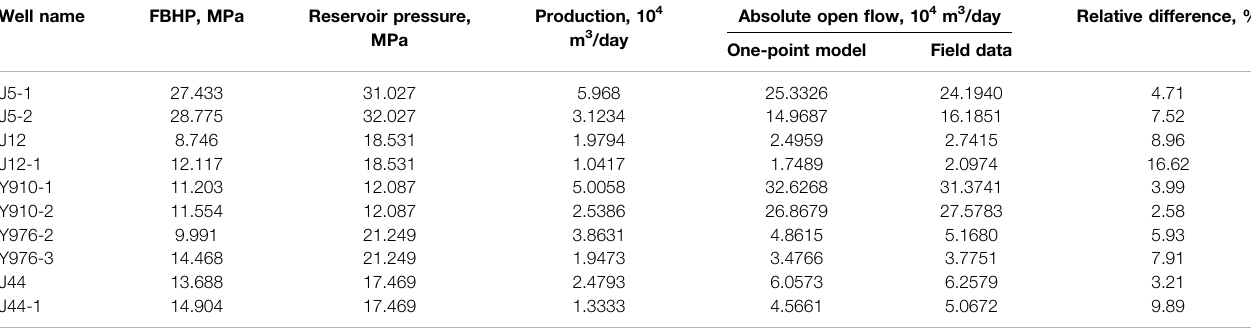
TABLE 6 | Comparison of productivity calculated by production data and productivity calculated by single-point